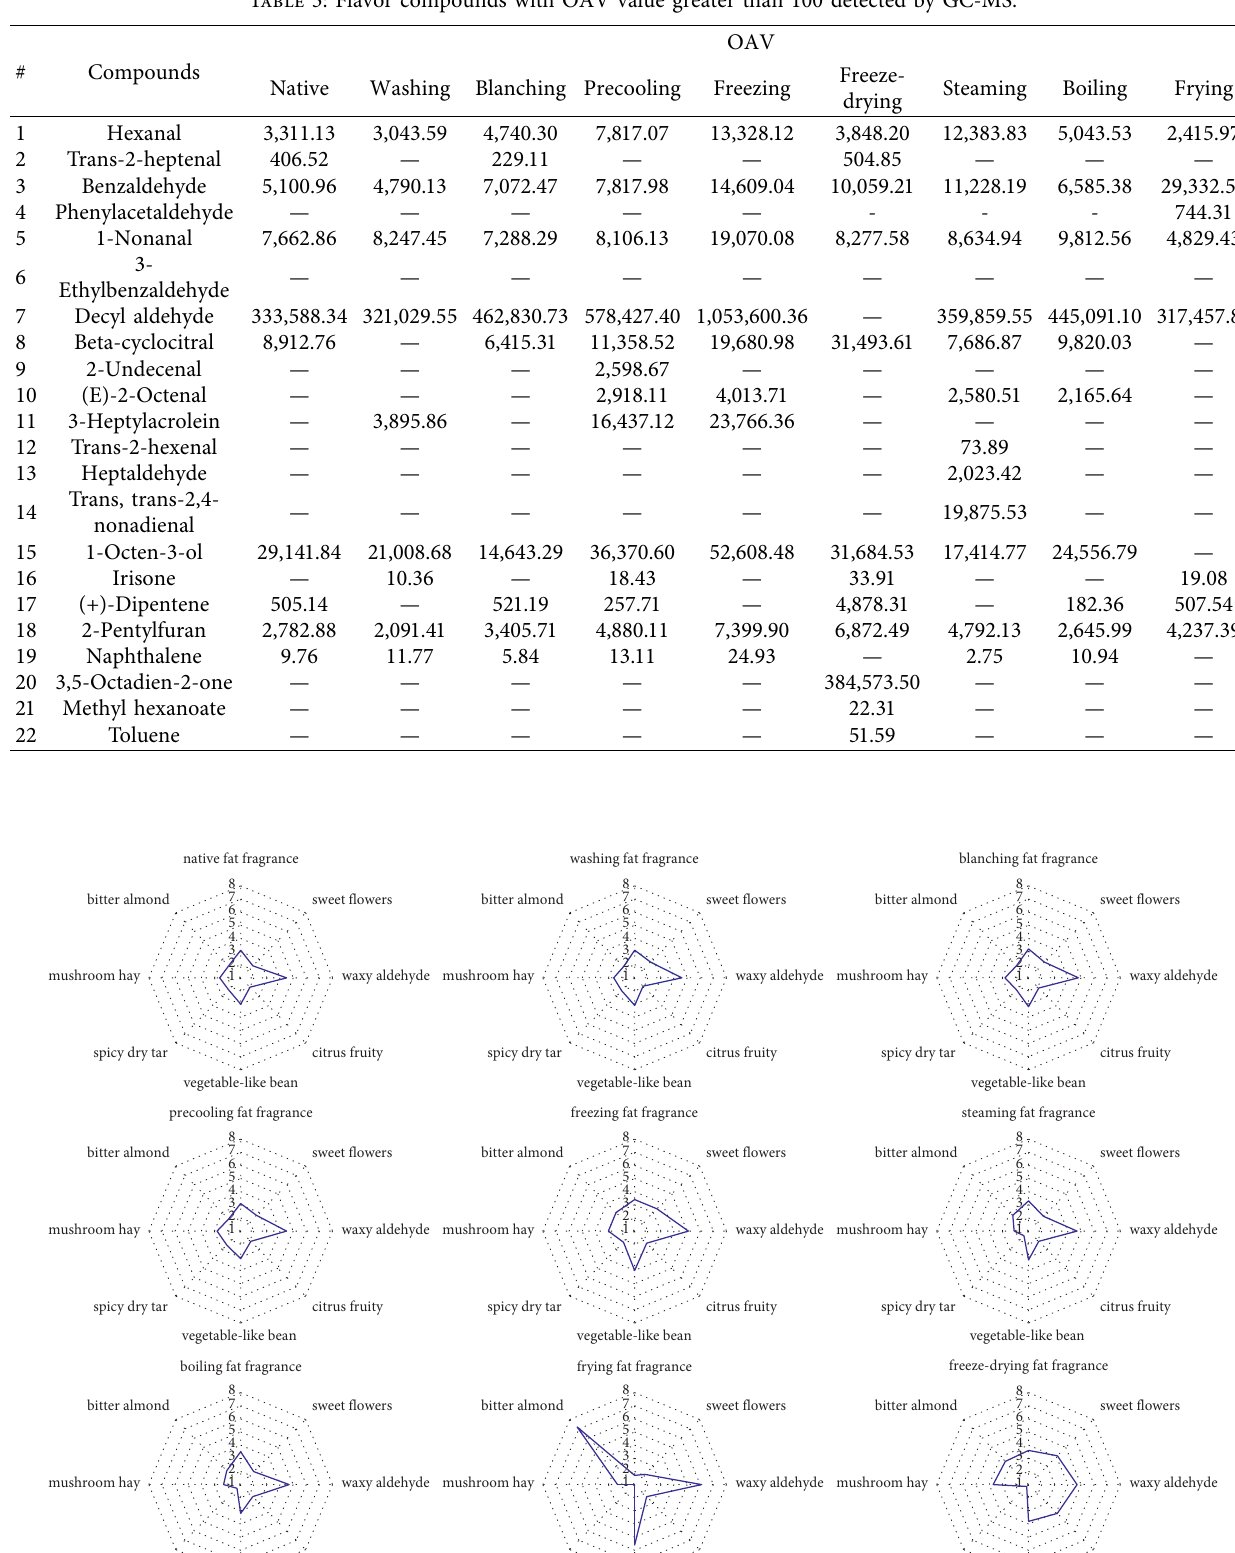
Table 3: Flavor compounds with OAV value greater than 100 detected by GC-MS.